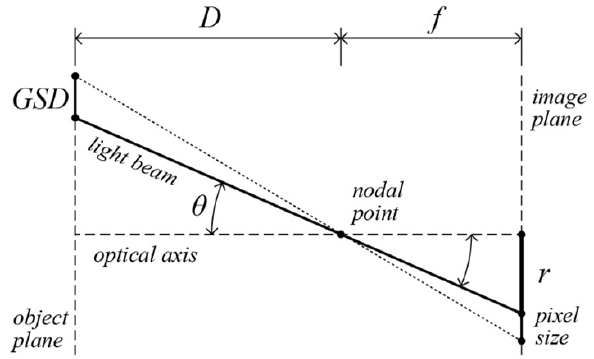
Figure 1. Pin-hole projection scheme. In this scheme it is easy to recognize a similarity between triangles. The following ratio is a very simple and standard tool that 𝑓𝑓 ∶ gives to the survey operator control above the results of the 𝐷𝐷 = 𝑝𝑝𝑝𝑝𝑝𝑝𝑝𝑝𝑝𝑝 𝑠𝑠𝑝𝑝𝑠𝑠𝑝𝑝 ∶ 𝐺𝐺𝐺𝐺𝐷𝐷 survey itself. The concept of GSD and the possibility of calculate/impose it, gives the link to the precision of the two or three-dimensional representation to be extracted from the